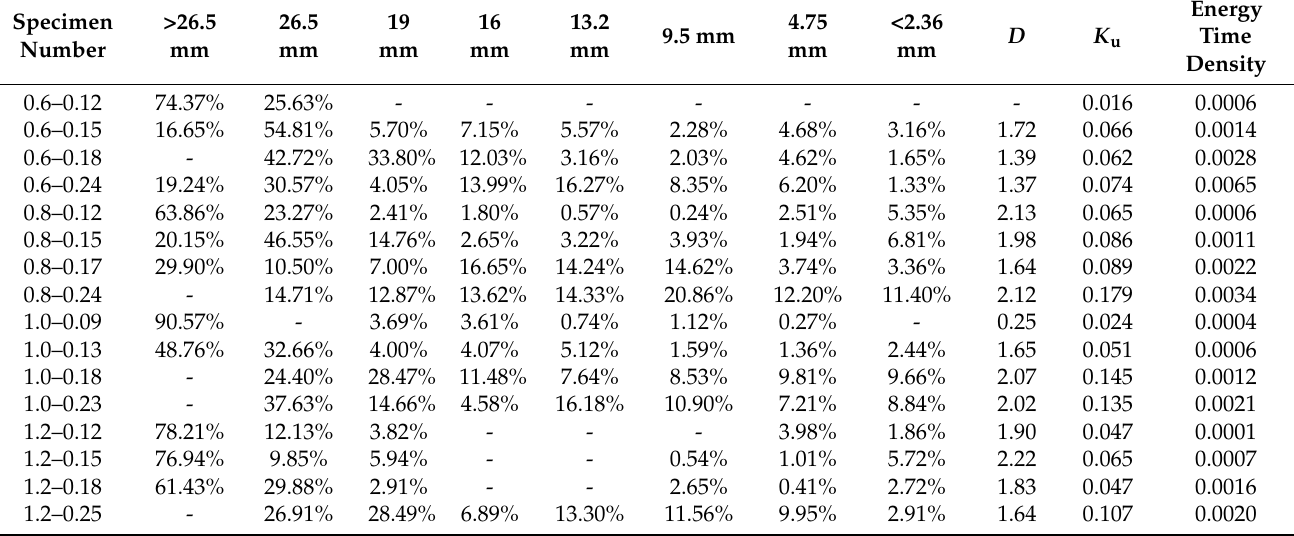
Table 3. Table of impact test sieve sizes corresponding to the